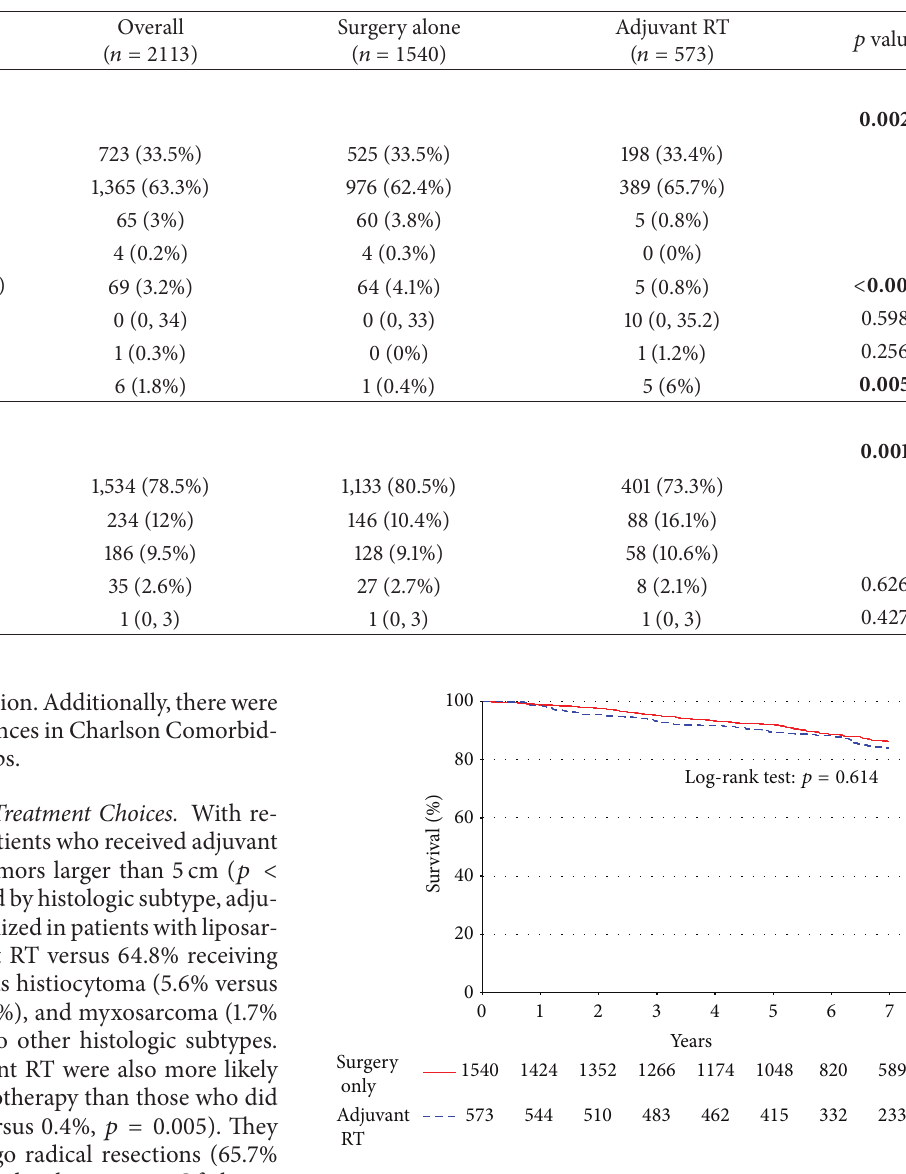
Figure 1: There is no difference in unadjusted survival for patients with well-differentiated tumors when stratified by adjuvant RT versus surgery